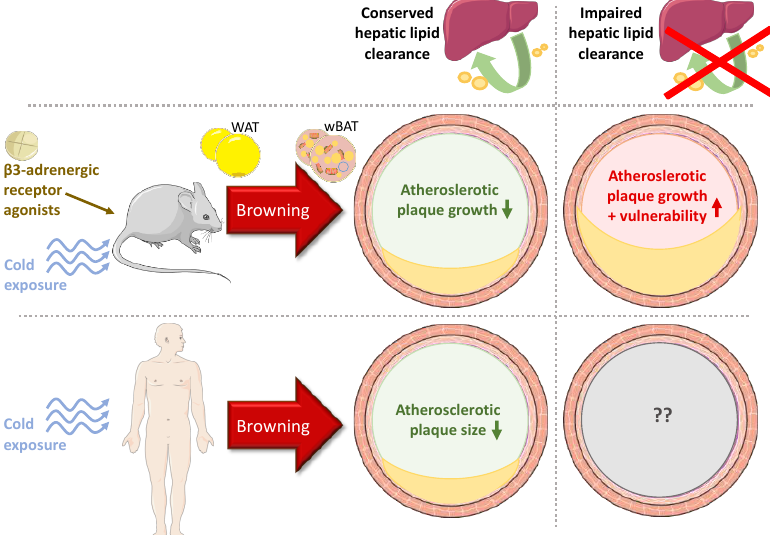
Figure 4. Summary of existing data from preclinical and clinical studies on the effects of white adipose tissue (WAT) browning on atherosclerosis. In the murine model with preserved hepatic clearance of lipids, the stimulation of WAT browning promoted by cold exposure or the use of β 3- adrenergic receptor agonists attenuates the development of atherosclerotic plaques. Conversely, the growth of atherosclerotic lesions and plaque vulnerability is promoted in mice with impaired hepatic clearance. In clinical studies, individuals exposed to cold conditions have increased white adipose tissue-derived brown-like adipose tissue (wBAT) differentiation and have smaller atherosclerotic plaques than individuals not exposed to cold. The situation with perturbed hepatic clearance of lipid remnants in atherosclerosis has not been studied in